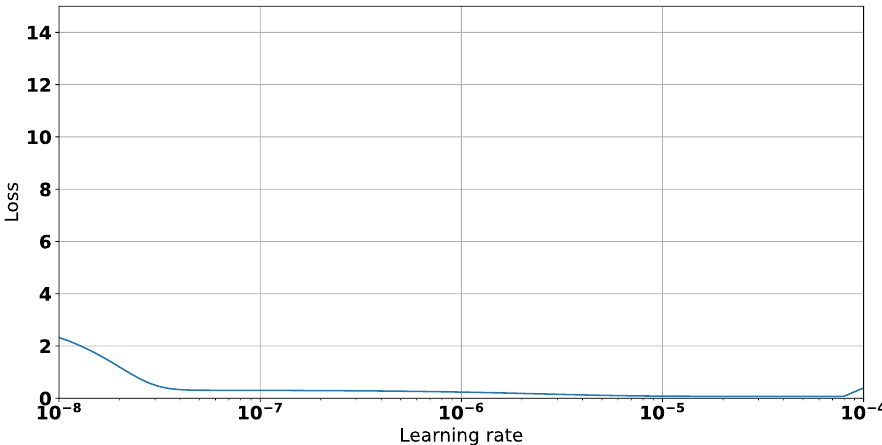
Version August 16, 2022 submitted to Appl. Sci.